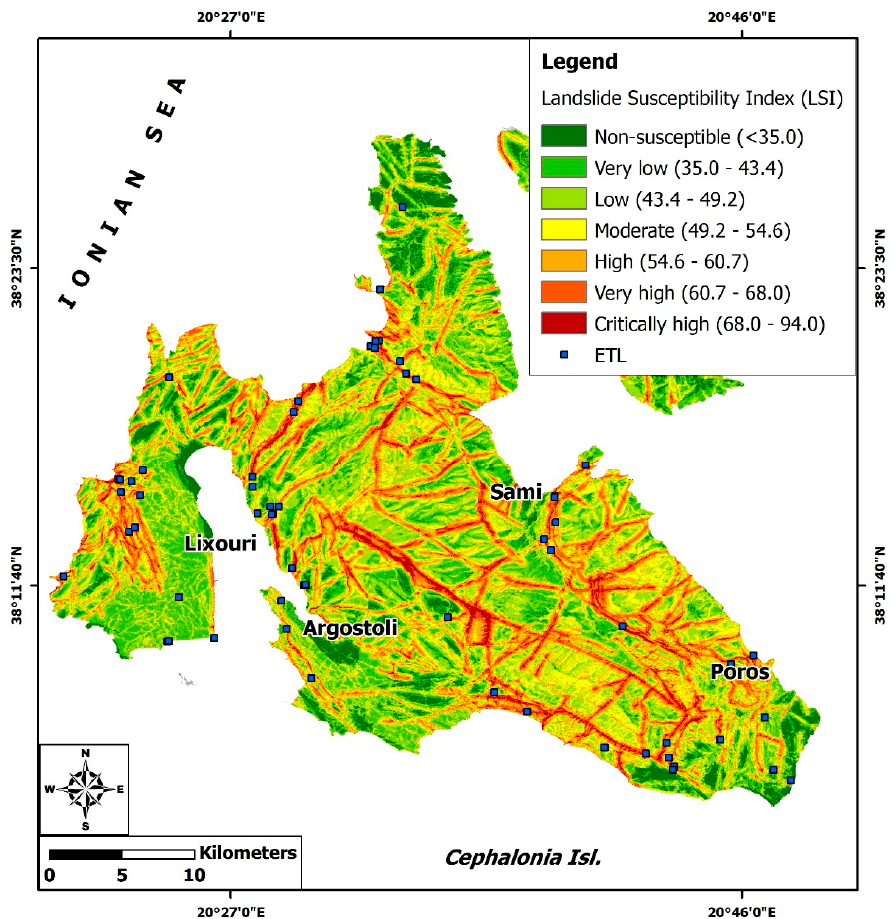
Figure 10. The landslide susceptibility index (LSI) map of Cephalonia Island, against the recorded